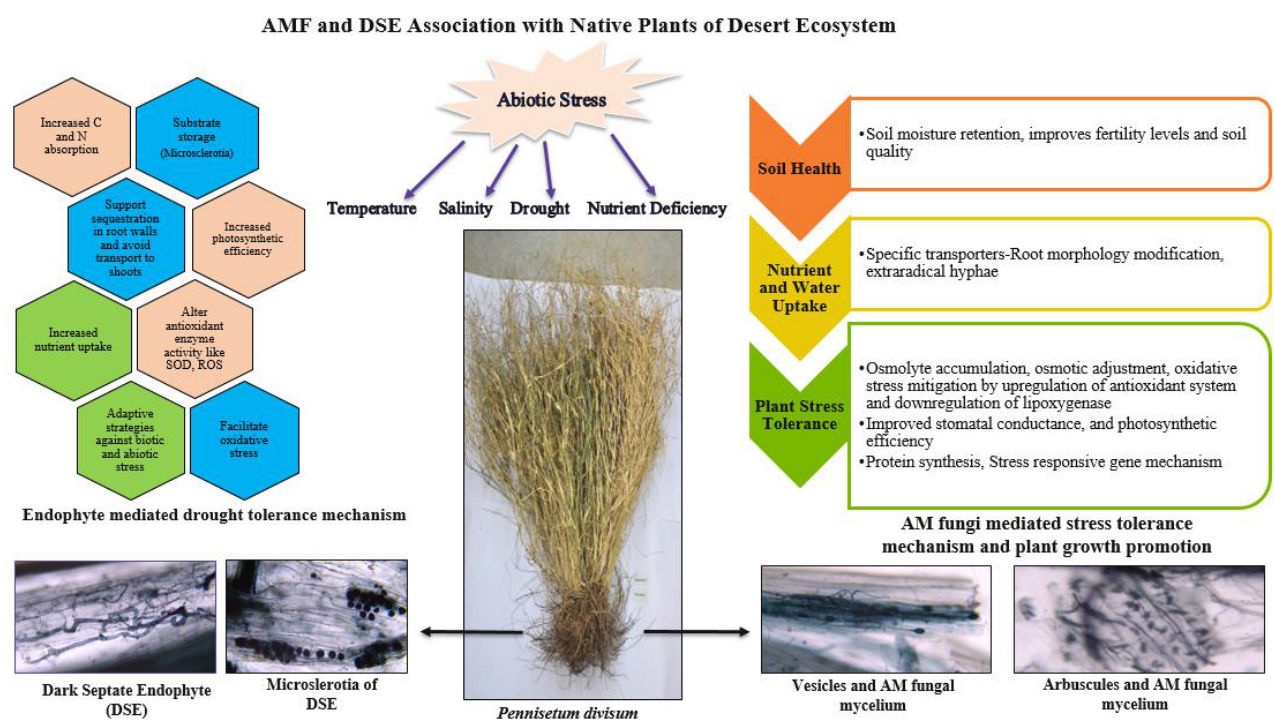
Figure 1. A schematic representation showing potential mechanisms mediated by AMF and DSEs to adopt and regulate drought stress tolerance and improve plant growth and performance of plants.